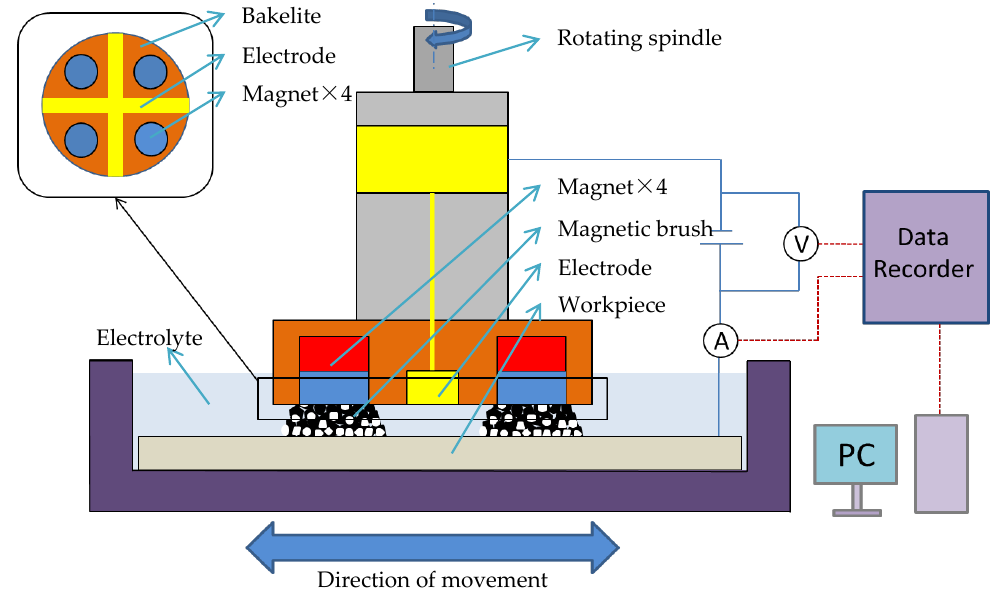
Figure 1. Schematic of magnetic abrasive finishing combined with electrolytic process (EMAF) processing